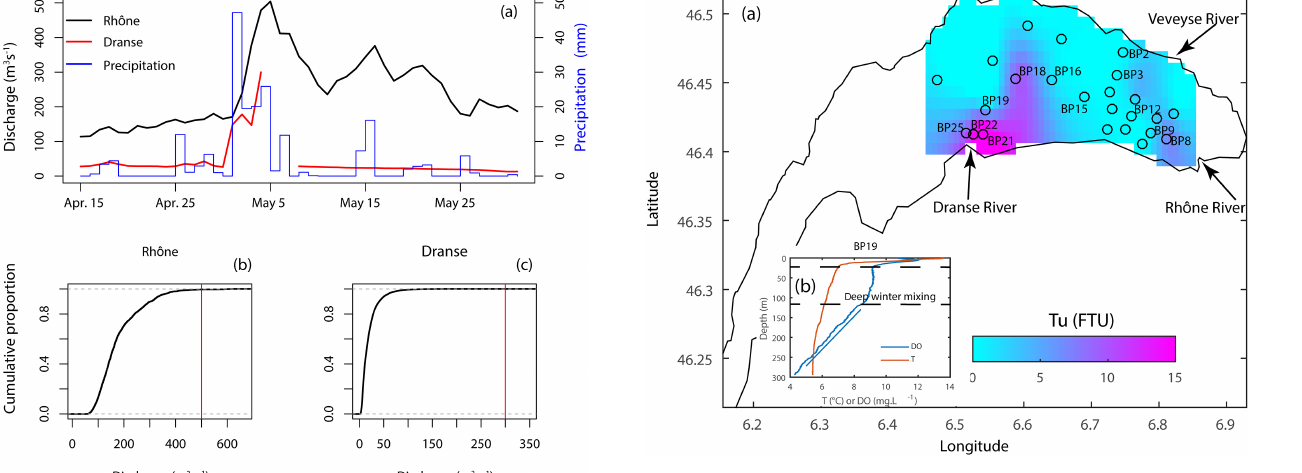
Figure 2. Spatial distribution of maximum hypolimnetic turbidity (40–300m depth) as a tracer for flooding river intrusions. Identi- fied stations are those for which profiles were provided in Fig. 3b. The inserted figure shows typical temperature and O 2 profiles for an undisturbed station. Note the linear decrease in O 2 with depth in the lower hypolimnion (below the deep winter maximum). GPS location of the CTD profiles is indicated in Table S5 in the Supple-